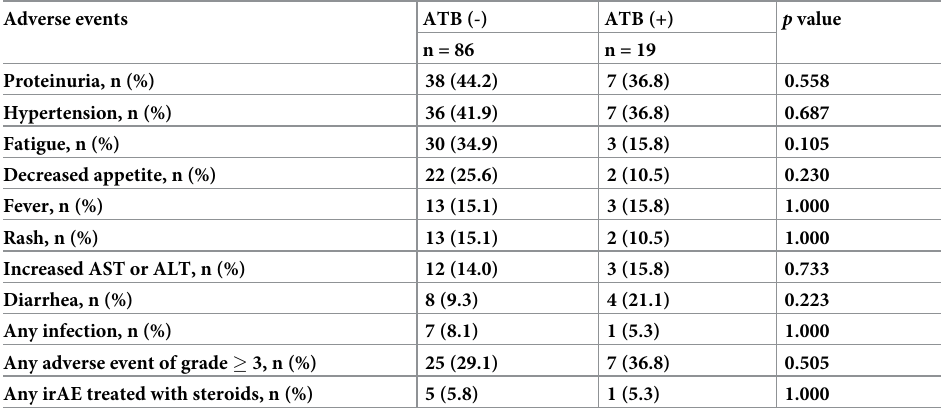
Table 5. Comparisons of adverse events between the ATB (-) and ATB (+) groups. Adverse events ATB (-) ATB (+) p value n = 86 n = 19 Proteinuria, n (%) 38 (44.2) 7 (36.8) 0.558 Hypertension, n (%) 36 (41.9) 7 (36.8) 0.687 Fatigue, n (%) 30 (34.9) 3 (15.8) 0.105 Decreased appetite, n (%) 22 (25.6) 2 (10.5) 0.230 Fever, n (%) 13 (15.1) 3 (15.8) 1.000 Rash, n (%) 13 (15.1) 2 (10.5) 1.000 Increased AST or ALT, n (%) 12 (14.0) 3 (15.8) 0.733 Diarrhea, n (%) 8 (9.3) 4 (21.1) 0.223 Any infection, n (%) 7 (8.1) 1 (5.3) 1.000 Any adverse event of grade � 3, n (%) 25 (29.1) 7 (36.8) 0.505 Any irAE treated with steroids, n (%) 5 (5.8) 1